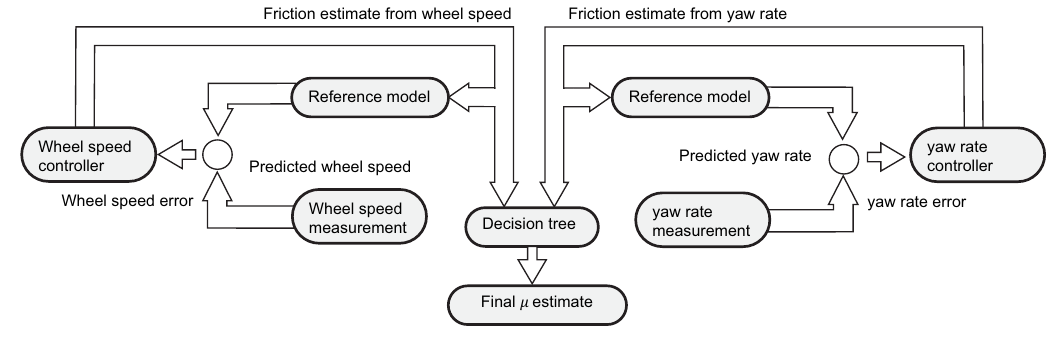
Figure 15. Estimation structure proposed in Shim et al. [103]. Figure adapted by the authors from